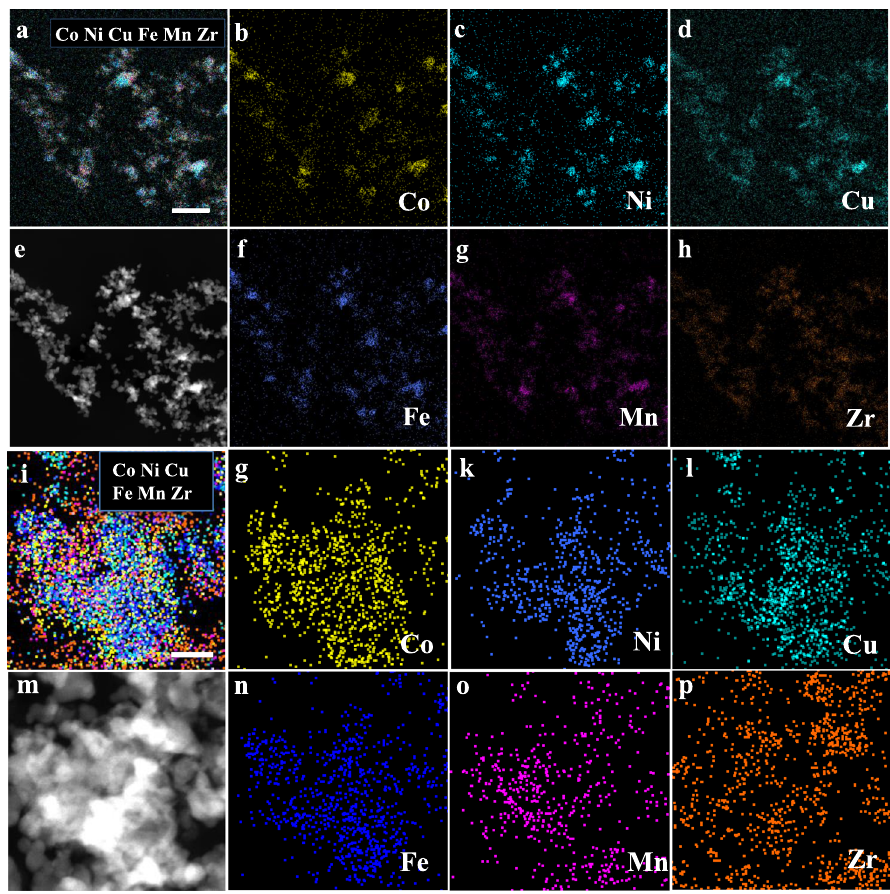
Fig. 8 The characterization of Zr 0.5 (NiFeCuMnCo) 0.5 O x after three redox cycles (600 °C H 2 /550 °C, Air). a – h STEM-HAADF image and EDS elemental maps of Zr 0.5 (NiFeCuMnCo) 0.5 O x after three redox cycles. Scale bar, 200nm. i – p STEM-HAADF image and EDS elemental maps of Zr 0.5 (NiFeCuMnCo) 0.5 O x after three redox cycles. Scale bar,